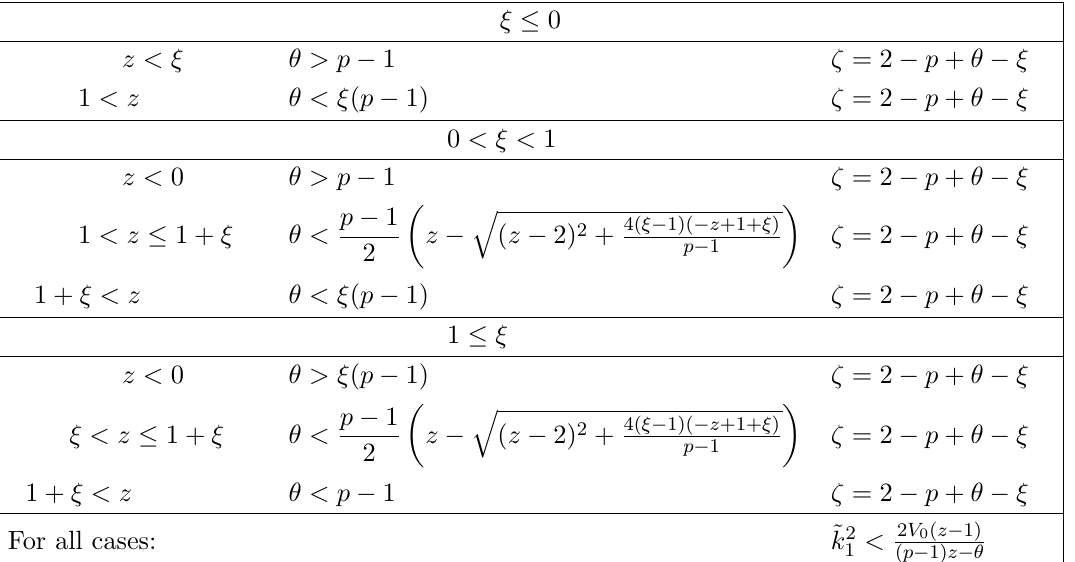
Table 1. Parameter range: Class I, V 0 > 0.